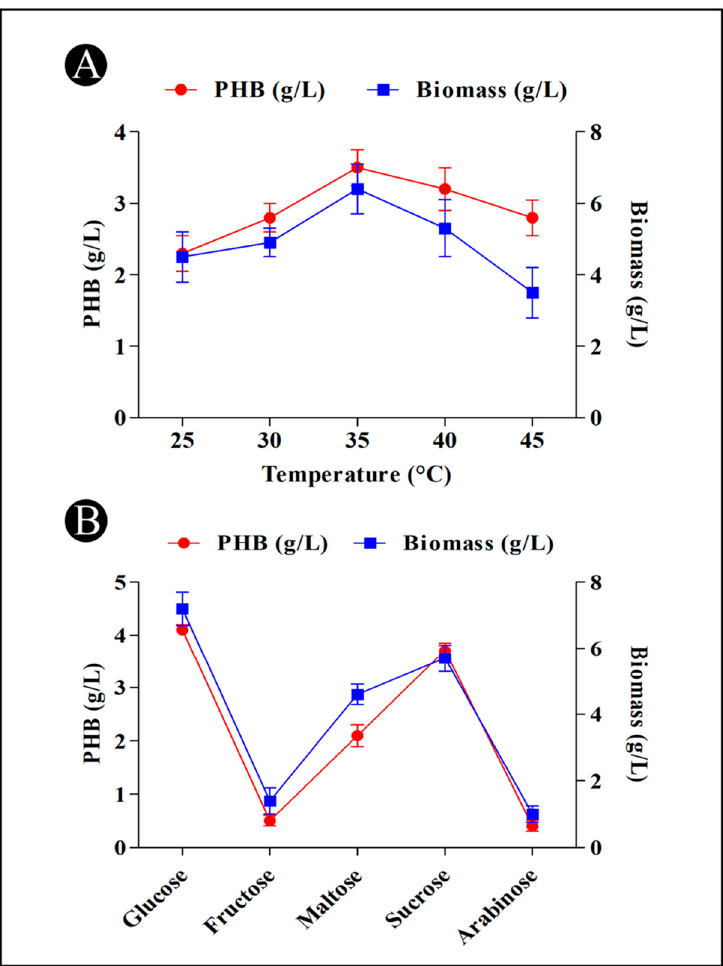
Figure 4. ( A ) Effect of incubation temperature on the PHB production by B. flexus strain HSA3. Figure 4. ( A ) E ff ect of incubation temperature on the PHB production by B. fl exus strain HSA3. ( B ) ( B ) Effect of different carbon sources on the PHB production by B. flexus strain E ff ect of di ff erent carbon sources on the PHB production by B. fl exus strain HSA3.